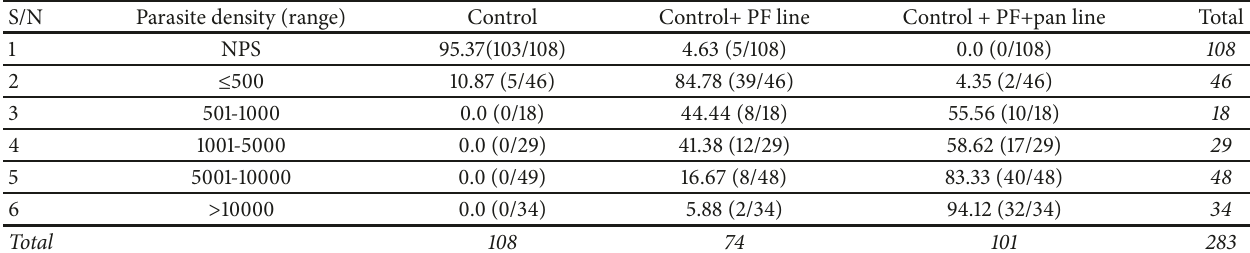
Table 1: Performance of SD Bioline (cid:2) mRDT Pf/Pan test lines with change is parasite density.